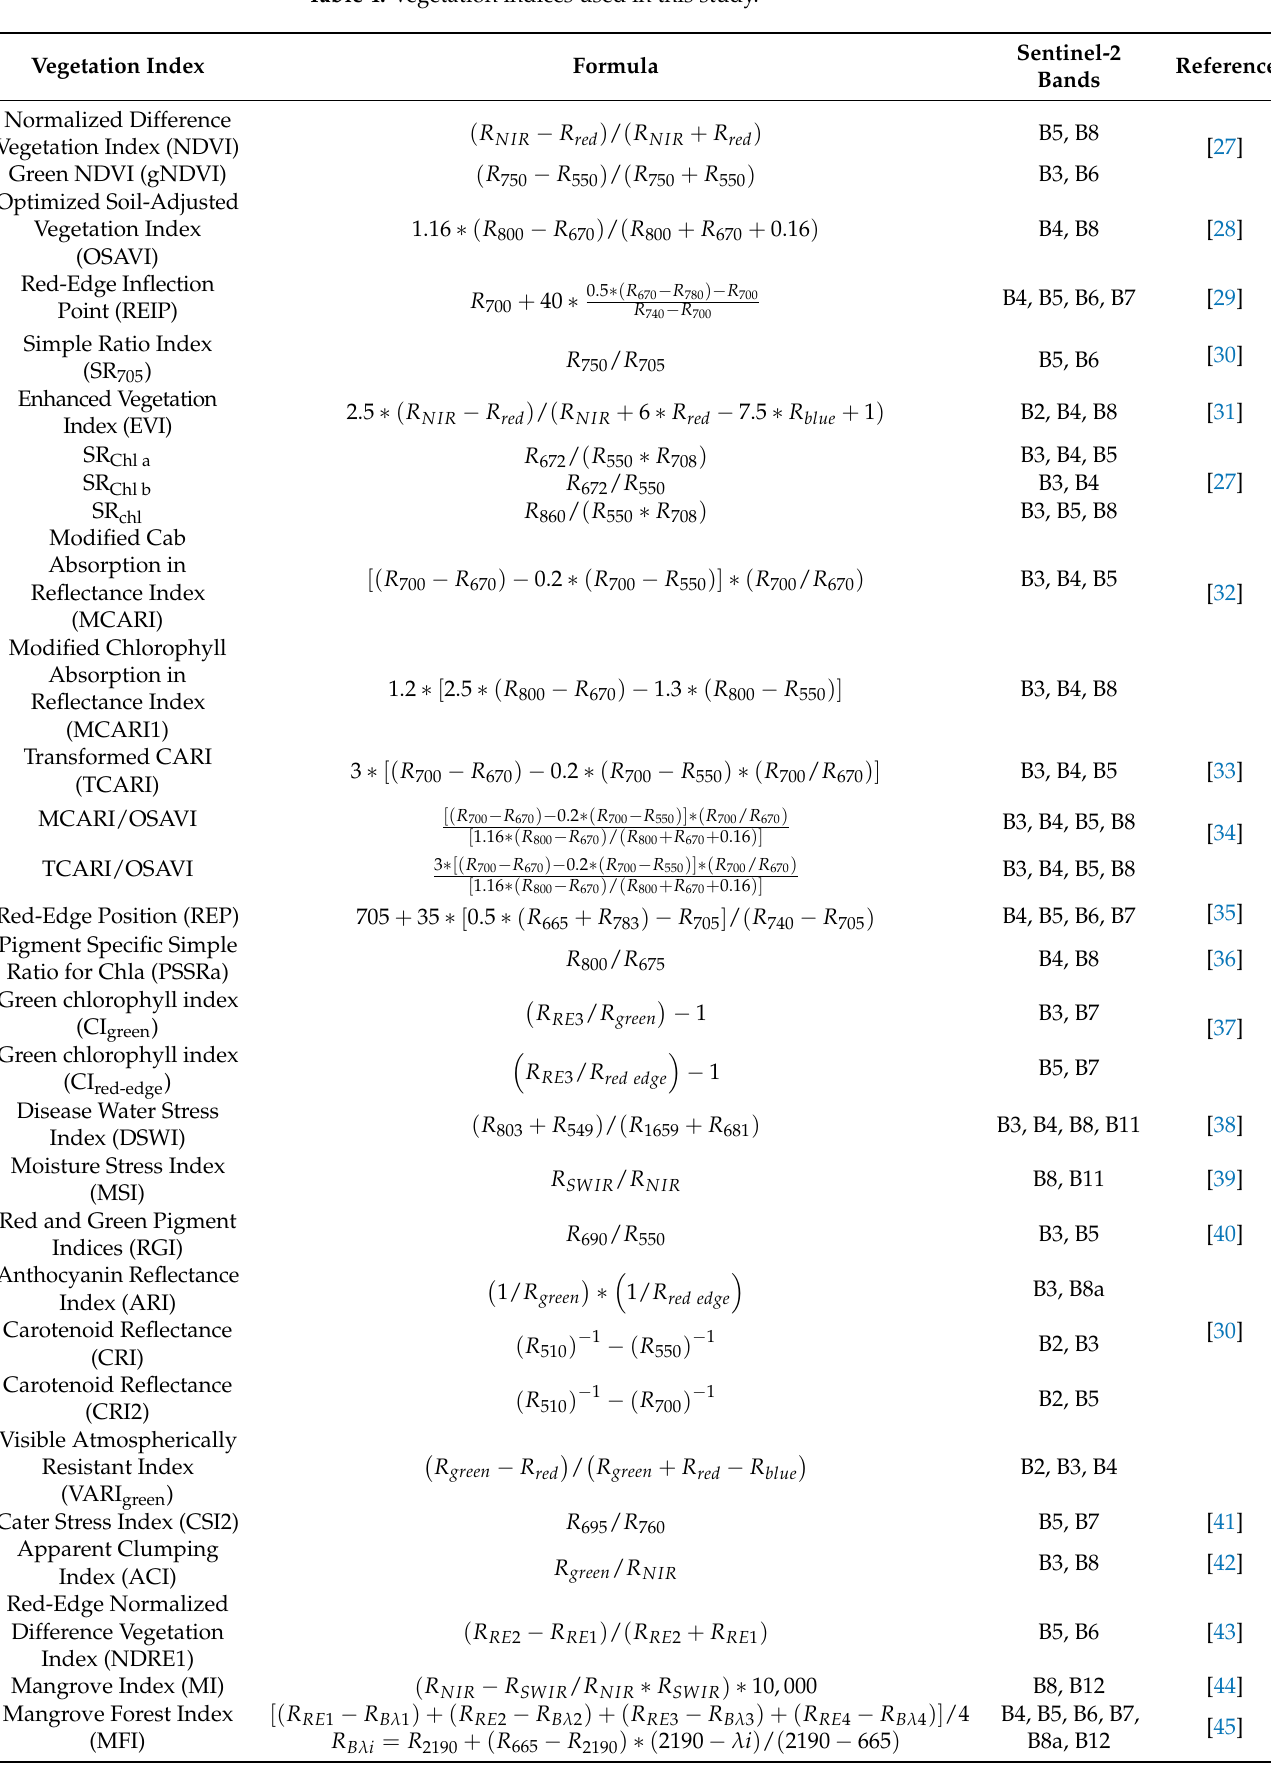
Table 4. Vegetation indices used in this